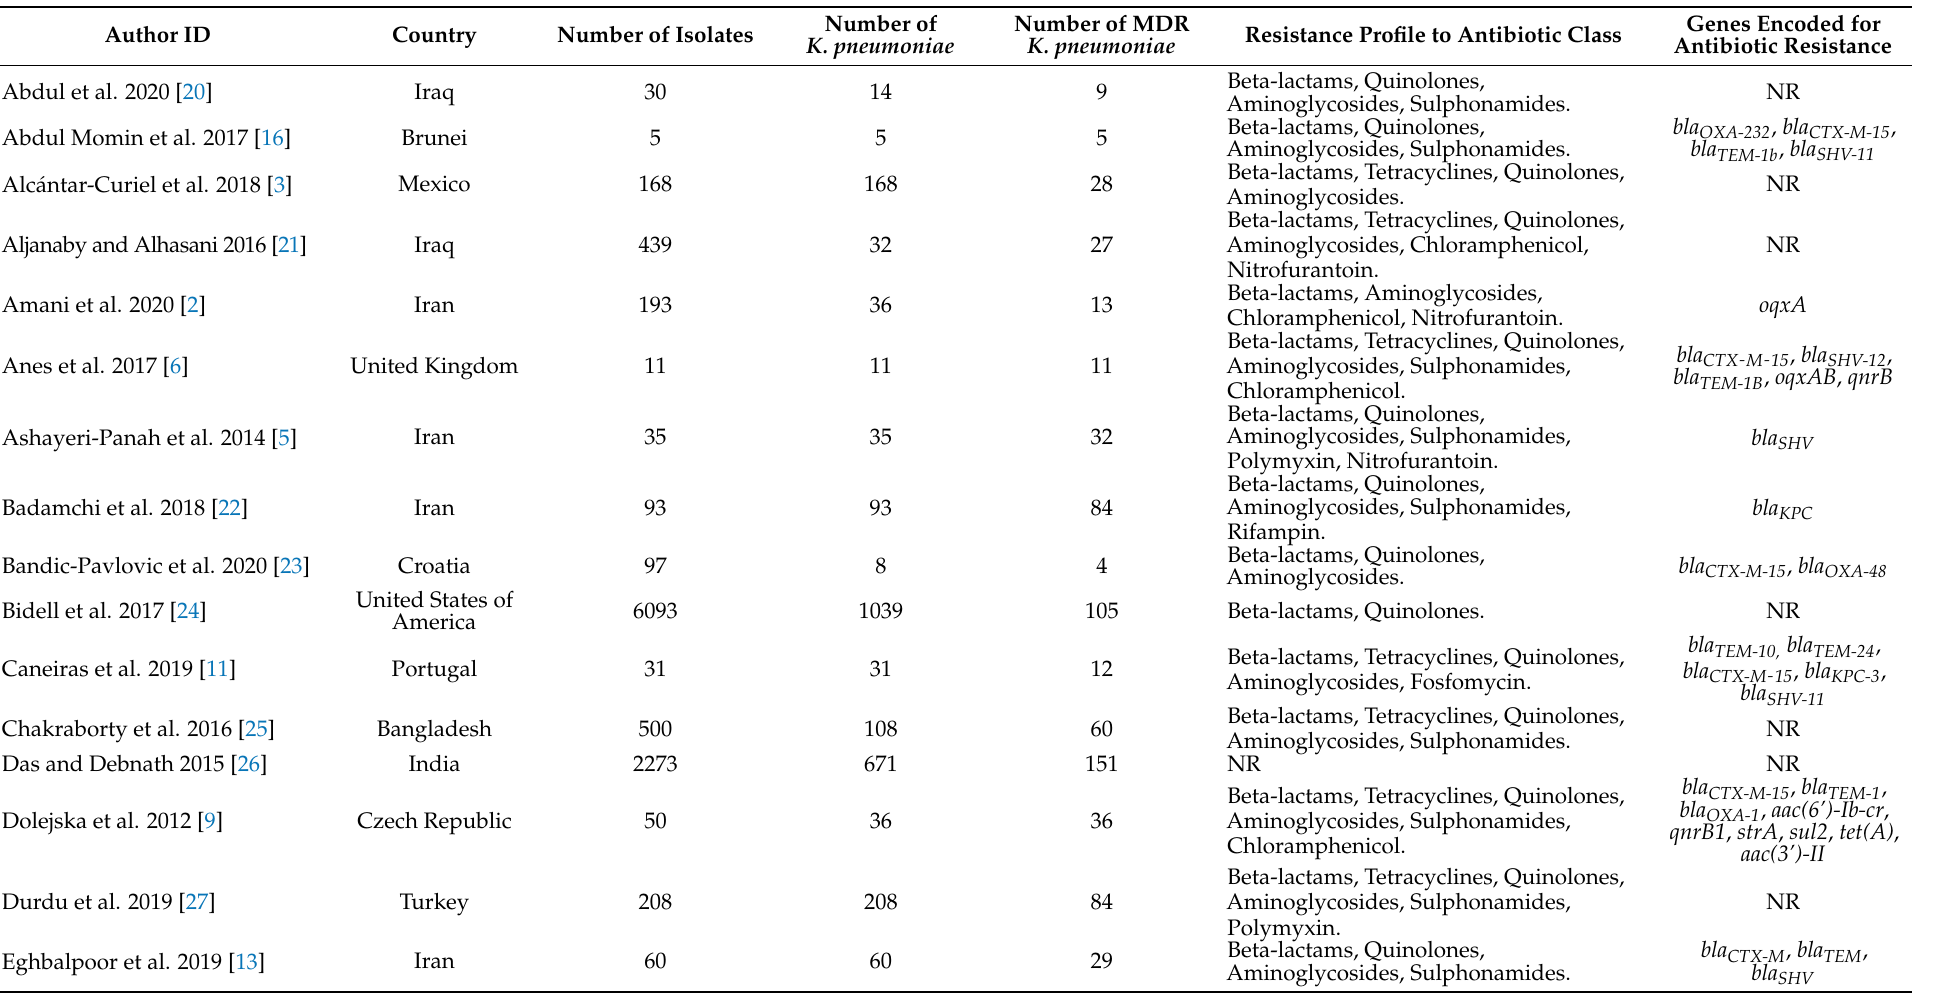
Table 1. Characteristics of the 47 included studies in this